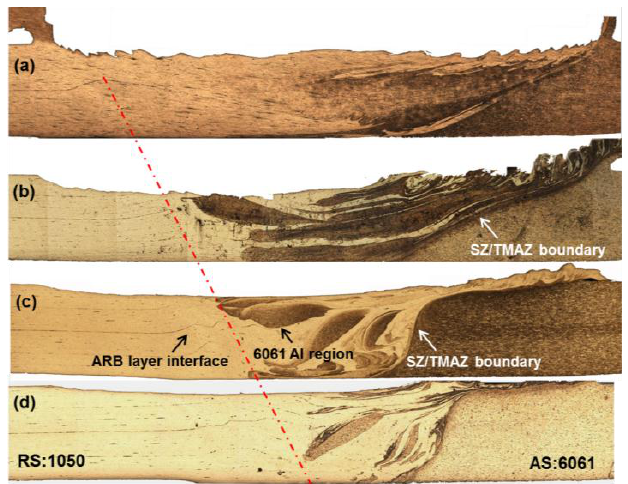
Figure 4. Optical microscopy (OM) images showing the cross-sectional macrostructure of the UFGed 1050/6061-T6 Al alloys dissimilar FSW joints produced at the different revolutionary pitches of ( a ) 0.5; ( b ) 0.75; ( c ) 1; and ( d ) 1.25 mm/rev.